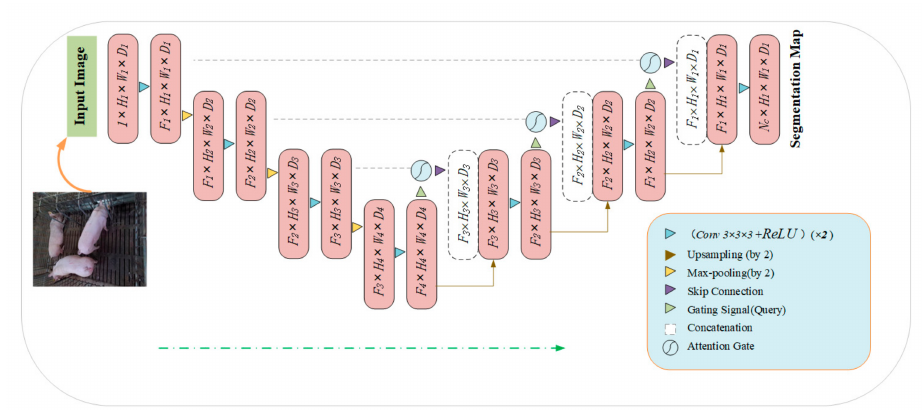
Figure 2. Block diagram of the Unet-Attention segmentation model.